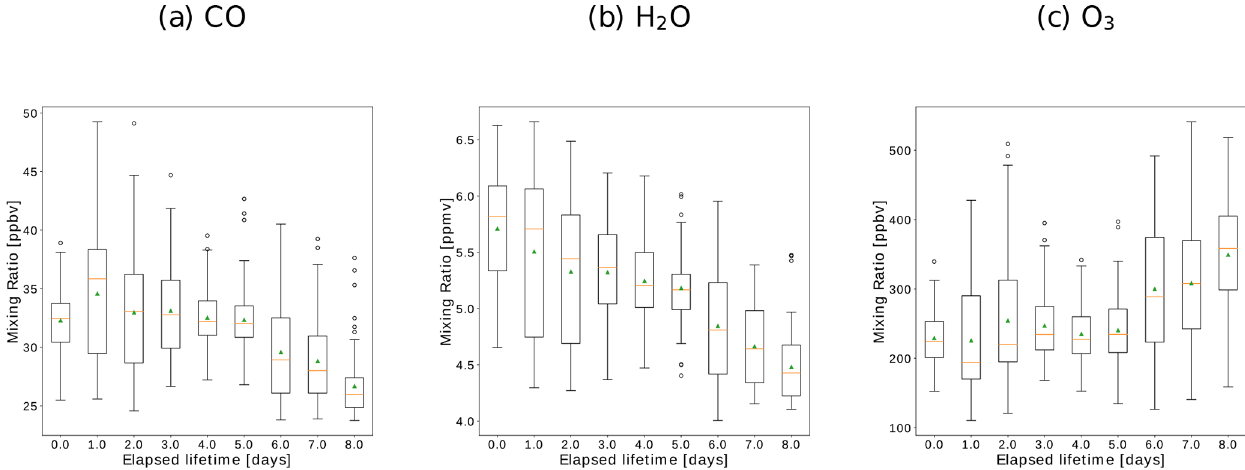
Figure 11. Chemical evolution of the chemical species of (a) CO, (b) H 2 O, and (c) O 3 along the exemplary PV cutoff shown in Fig. 10. Box-and-whisker plots are as in Fig.